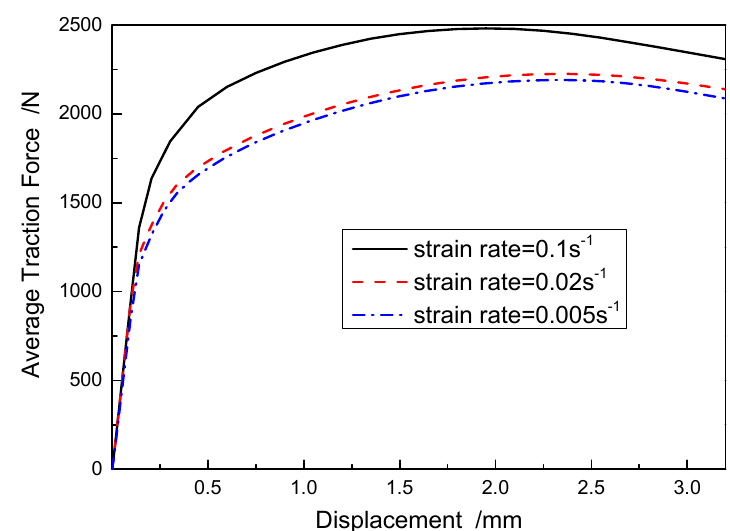
Figure 11. Specimen geometry of the biaxial tensile (unit: mm).